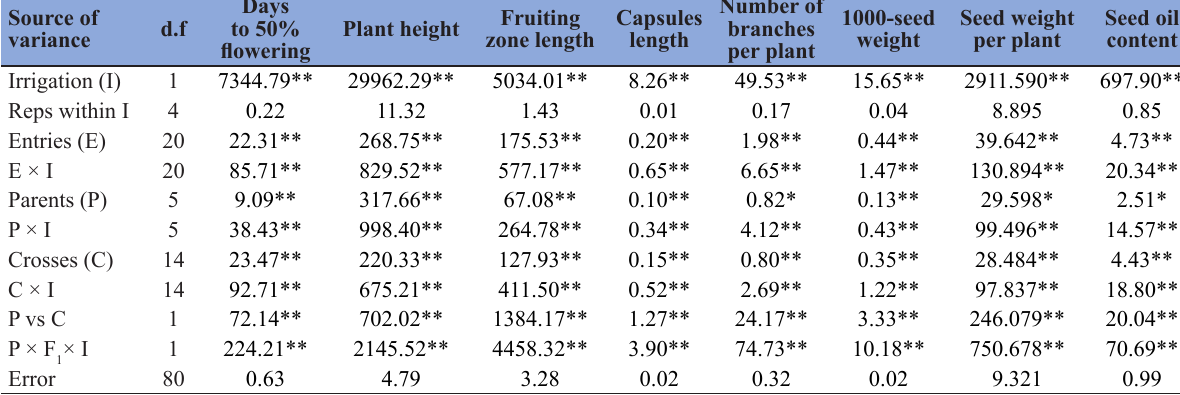
Note: *, ** refers to significant at 5% and highly significant at 1%,